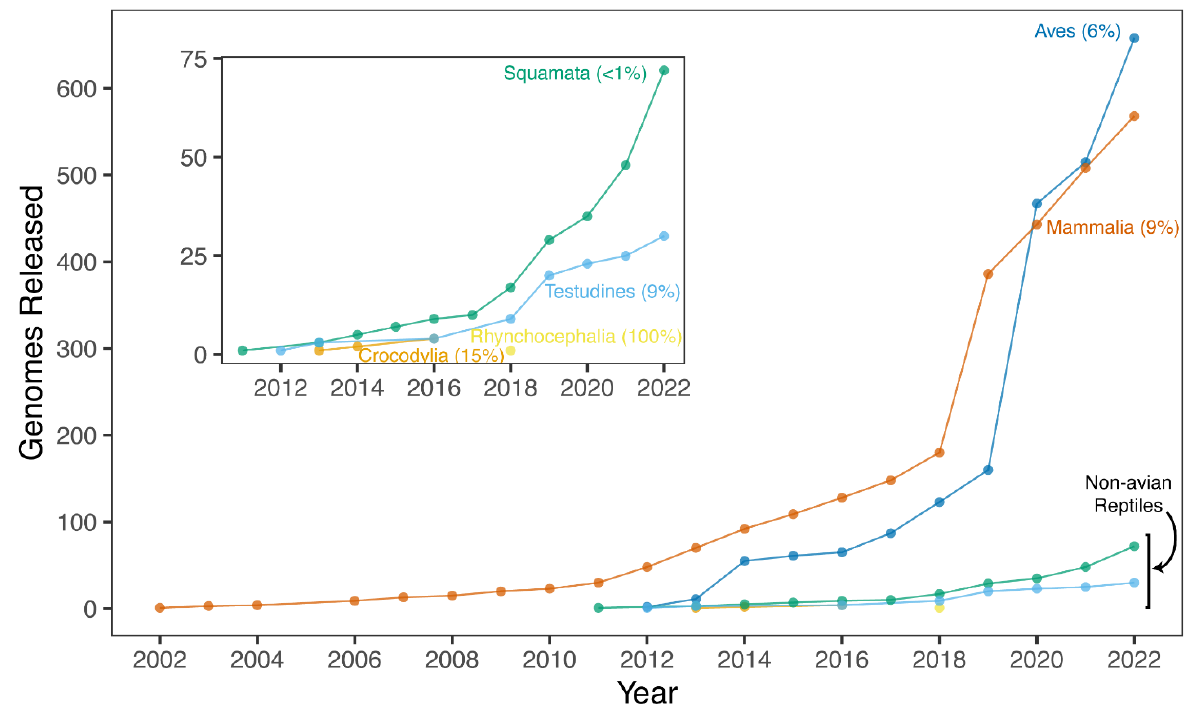
Figure 2. Temporal accumulation of genomes available on NCBI for major amniote clades (data retrieved 1 December 2022). Inset: Details of the growth in the number of available genomes for non-avian reptiles. Note: The counts from this dataset represent a subset of the full non-avian reptile genomes dataset presented in Figure 3, as many genomes are available from sources other than NCBI. This figure was inspired by Bravo et al. [148].